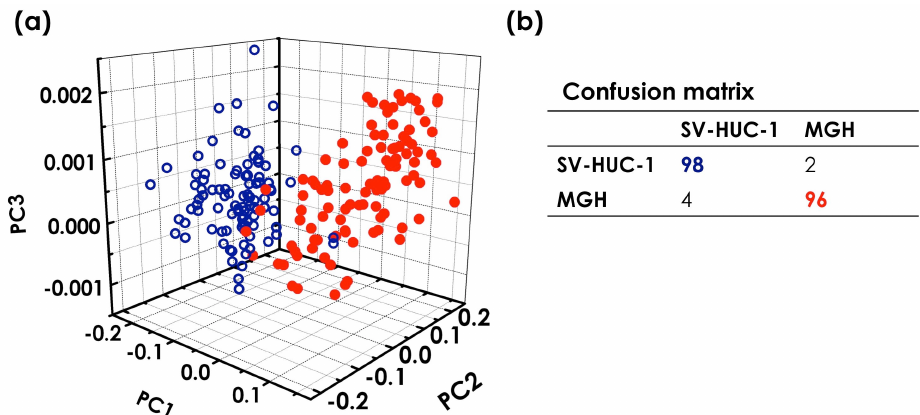
Figure 7. ( a ) 3D PCA scope plot of all individual modulated Raman spectra for 100 cancer (red dot) and 100 non-cancer (blue circle) cells; ( b ) confusion